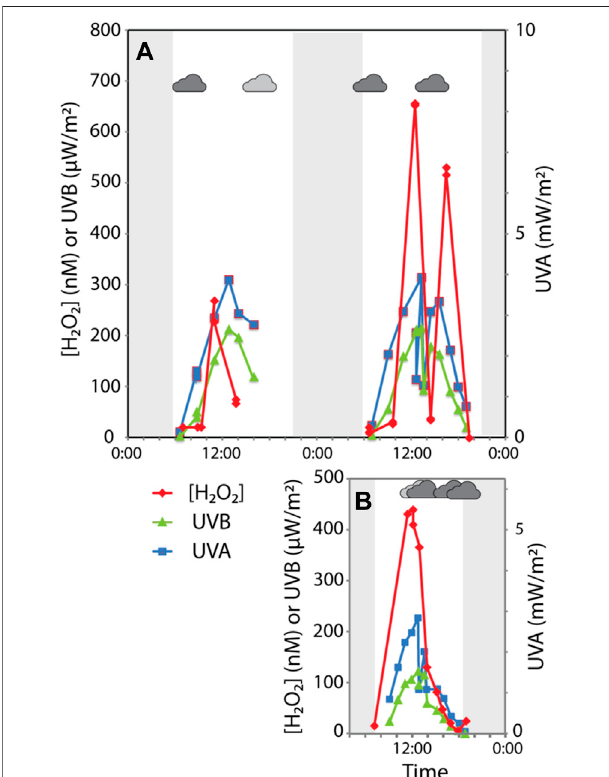
FIGURE3| DielvariationsinUVA/BandhydrogenperoxideinElkSpring (A) July 17 – 18, 2017. Sudden variations in UVA/UVB caused by partly cloudy conditions (indicated by small cloud shape). Windy conditions occurred between 13:00 and 16:00 on July 17th (stippled area). Shaded areas representtimeperiod whenthesunwasbelowthehorizon. (B) 29September 2017. Sudden variations in UVA/UVB caused by partly cloudy conditions.